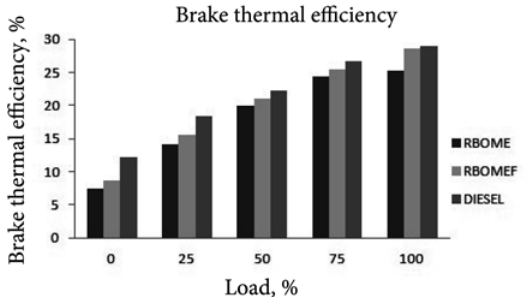
Fig. 5. Brake thermal efficiency with respect to load